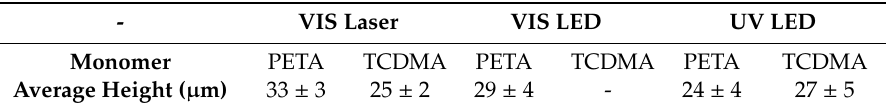
Table 4. Average heights of microtips with their uncertainties for optical power range from P = 5 µW to P = 40 µW and time of exposure from t = 1 s to t = 60 s.